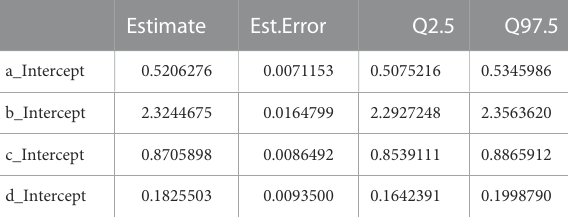
TABLE 1 Estimation of the median, standard deviation and quantile of order 0.025 and 0.975 of the parameters of the model.